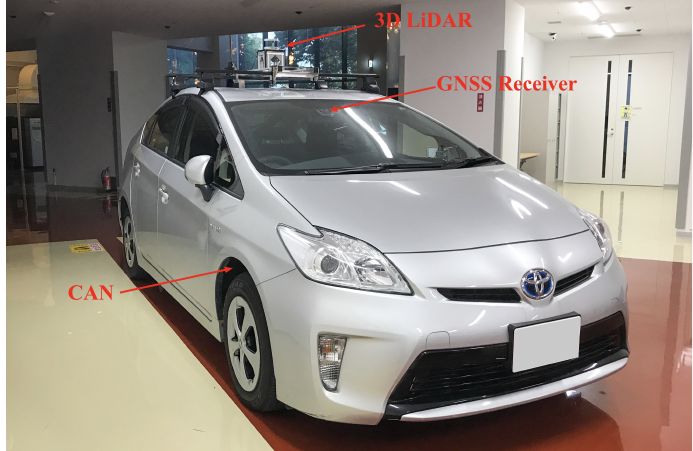
Figure 7. Experimental